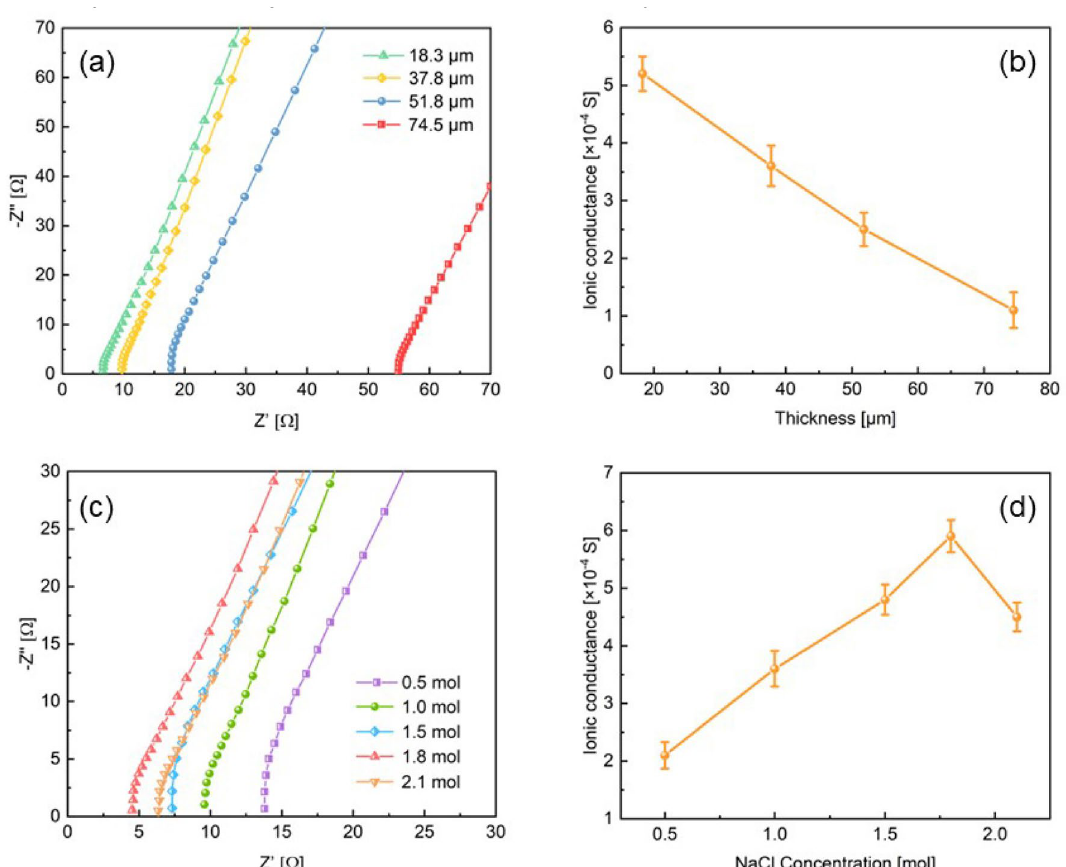
Figure 3. ( a ) EIS curves of the electrolyte with different thicknesses. ( b ) The thickness-dependent ionic conductance of the electrolyte. ( c ) EIS curves of the electrolyte with different NaCl content. ( d ) The NaCl content-dependent ionic conductance of the